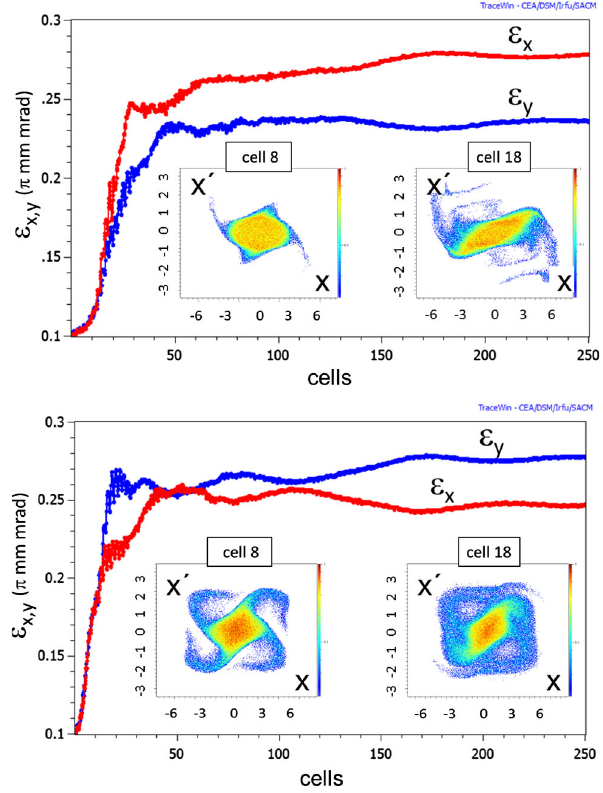
FIG. 6. rms emittances with phase space inserts for k ¼ 120 °, k ¼ 73 ° for KV beam (top graph) and waterbag 0 ;x;y x;y distribution beam (bottom